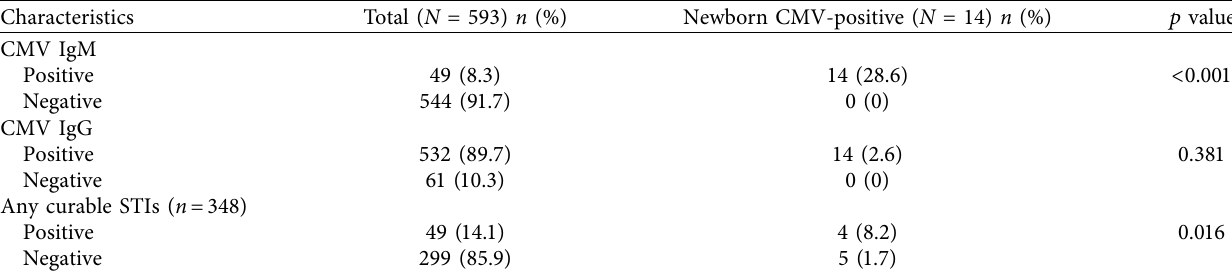
Table 2: Maternal STIs and CMV seropositivity with newborn congenital CMV infection.